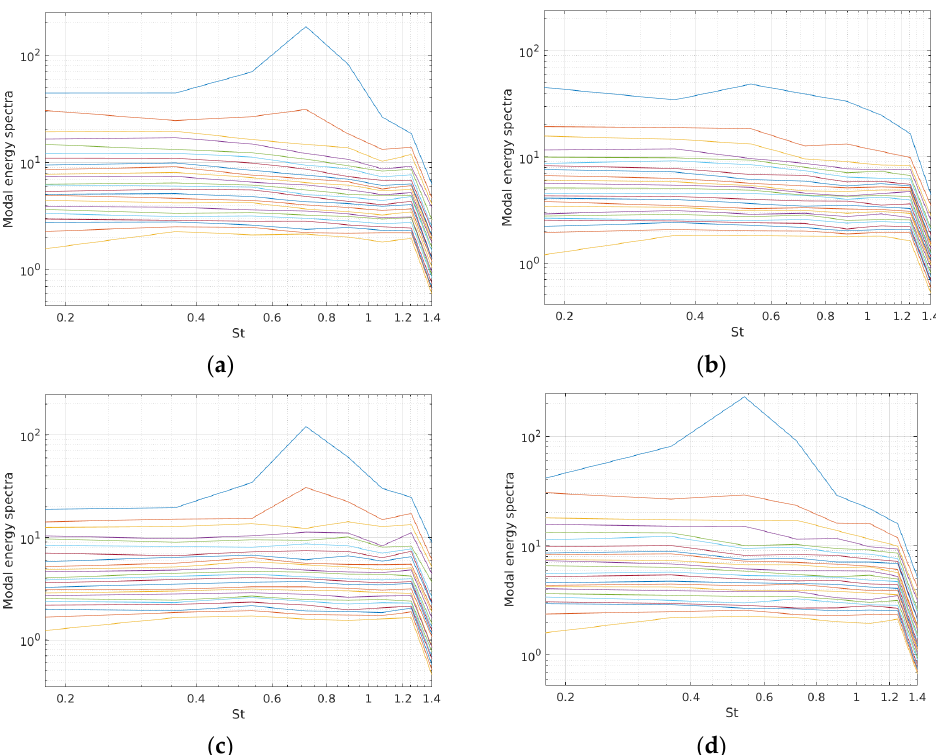
Figure 21. Modal energy spectra for case ‘0-0’ of x -component ( a ) and z -component ( c ) of velocity and for case ‘0-60’ x -component ( b ) and z -component ( d ) of velocity on XZ symmetry plane. The different colour lines represent the different modes.